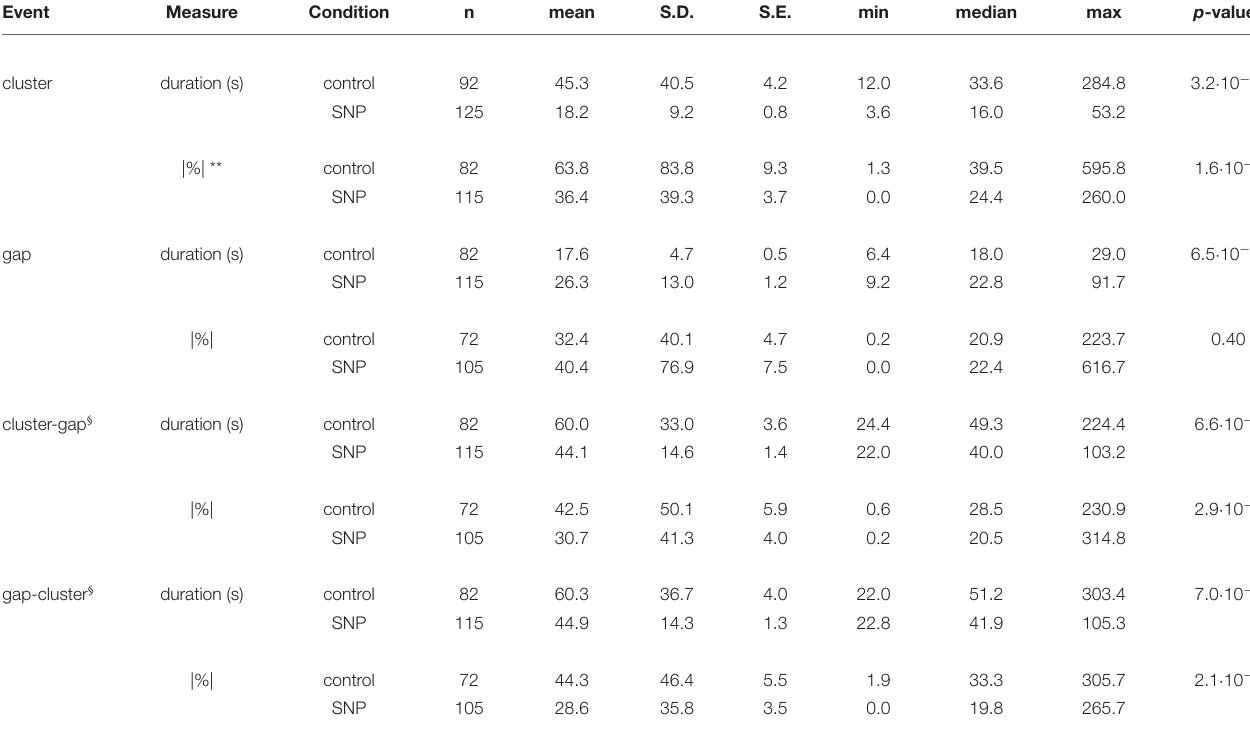
TABLE 1 | Cluster and gap statistics for ten intestines under control conditions and after addition of 1 µ M SNP (see Figure 4